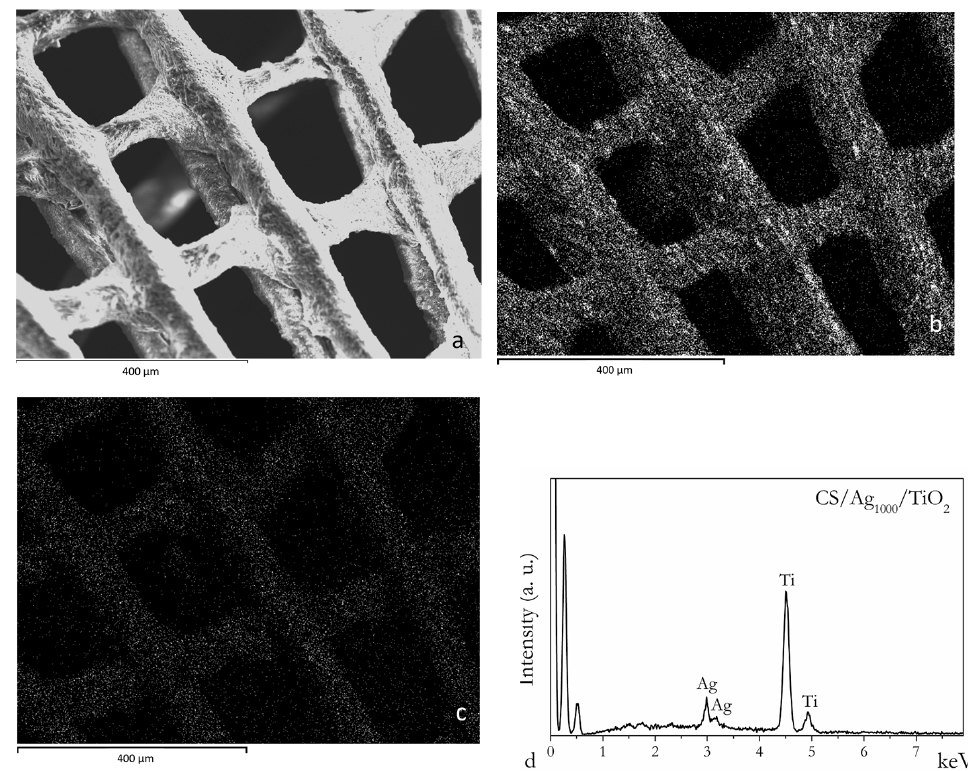
Figure 4. SEM image (magnification 150 × ) of CS/Ag 1000 /TiO 2 ( a ); EDS elemental Ti ( b ) and Ag ( c ) maps and EDS analysis ( d ) acquired on ( a ).